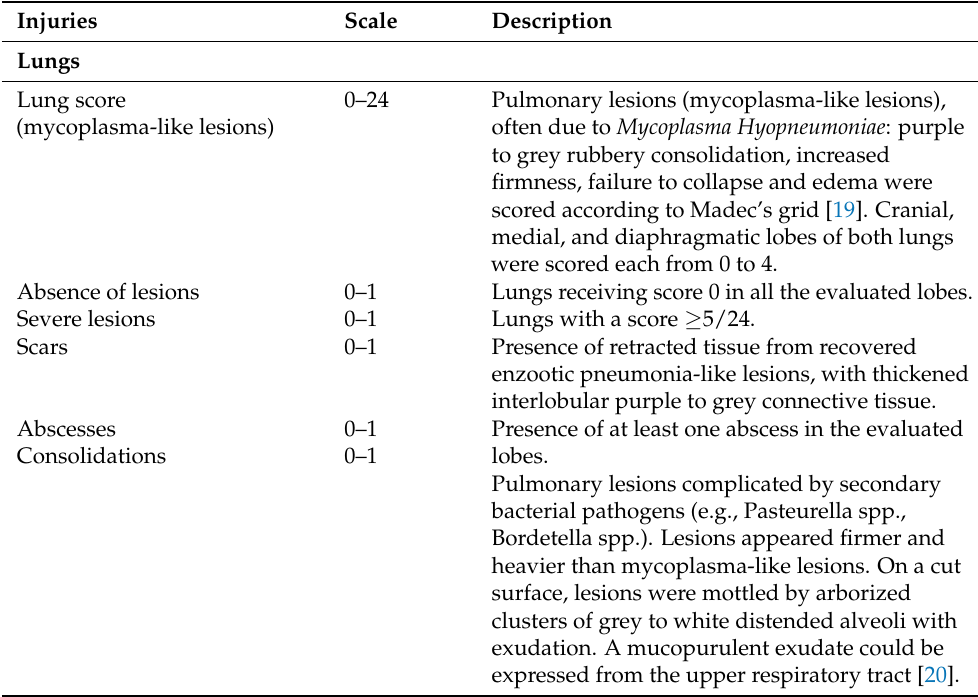
Table 1. Scoring system used for the assessment of pleural, liver, and lung lesions at slaughter from January to September. A total number of 525 batches of pigs (135 pigs per batch, around 170 kg weight) were monitored. Reprinted and slightly adapted with permission from Elsevier